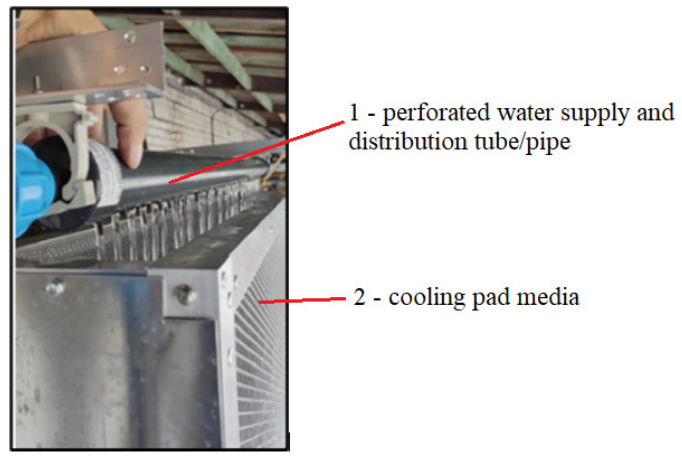
Figure 2. Water distribution system on a cooling pad surface.